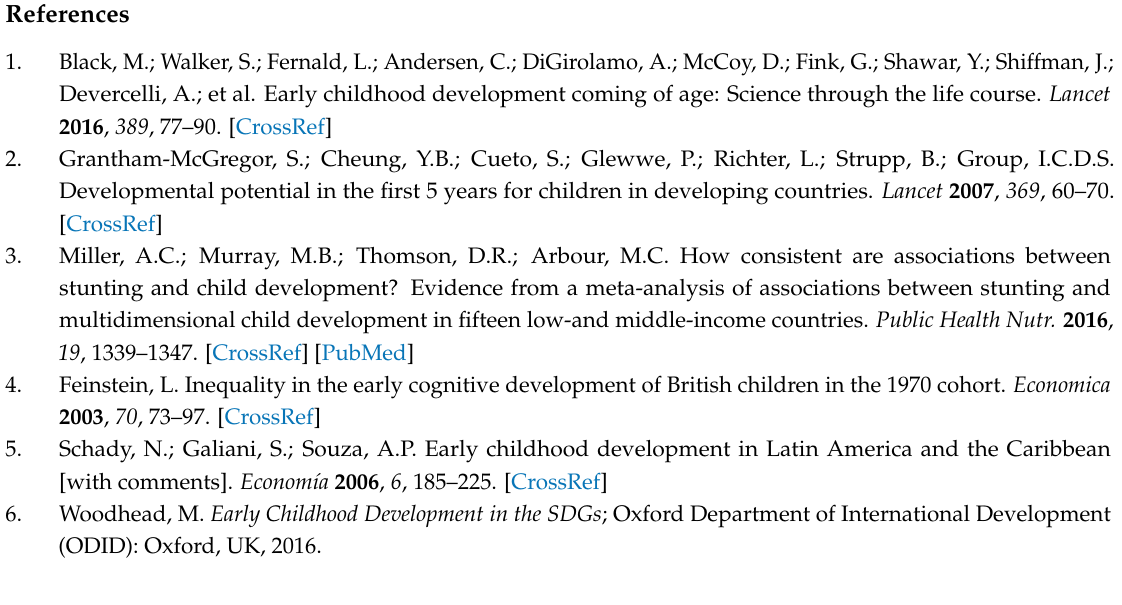
Table S1: Early Childhood Development